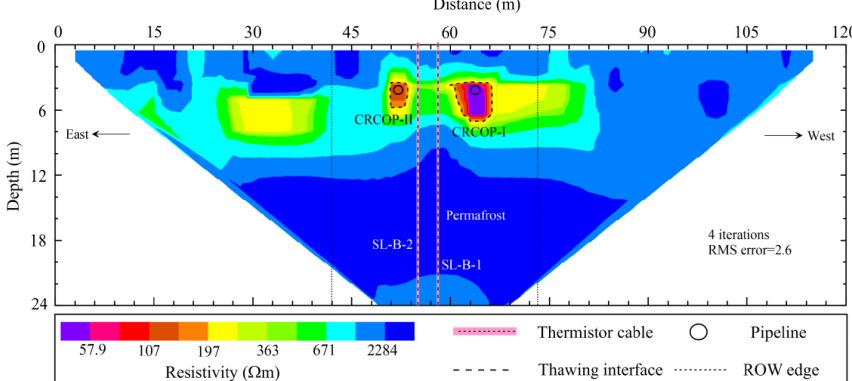
Figure D2. Inversion results of electrical imaging along the P-SL profile at the SL site, carried out in April 2018.